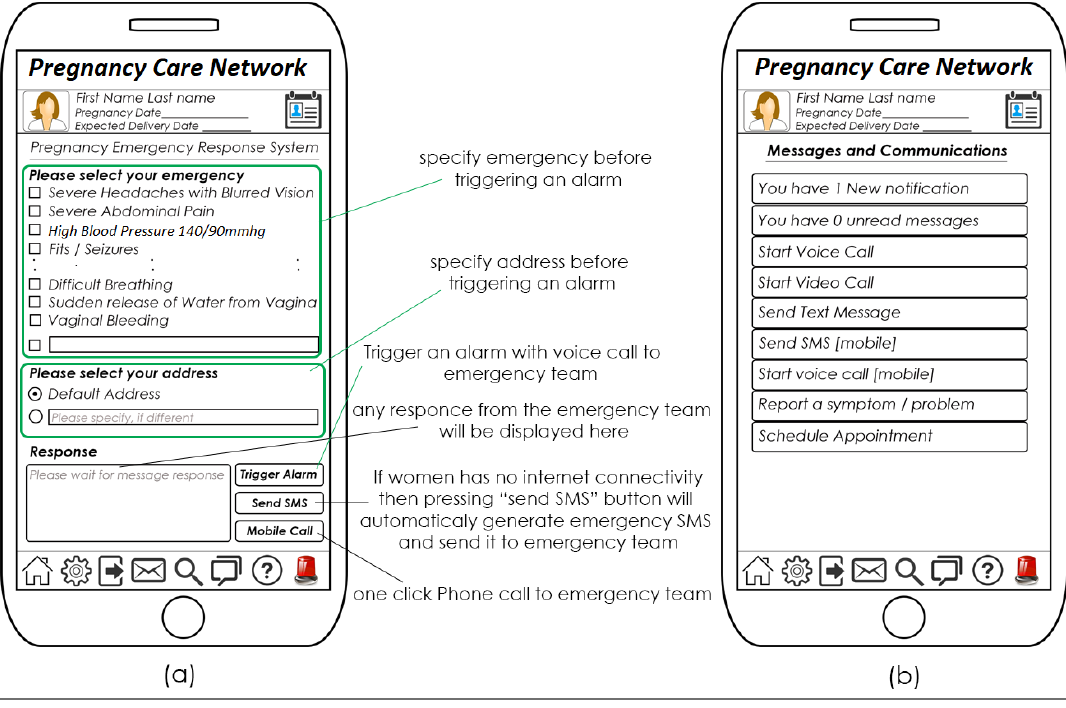
Figure 6. ( a ) Main screen for triggering the pregnancy emergency response system; ( b ) main screen for communication with health